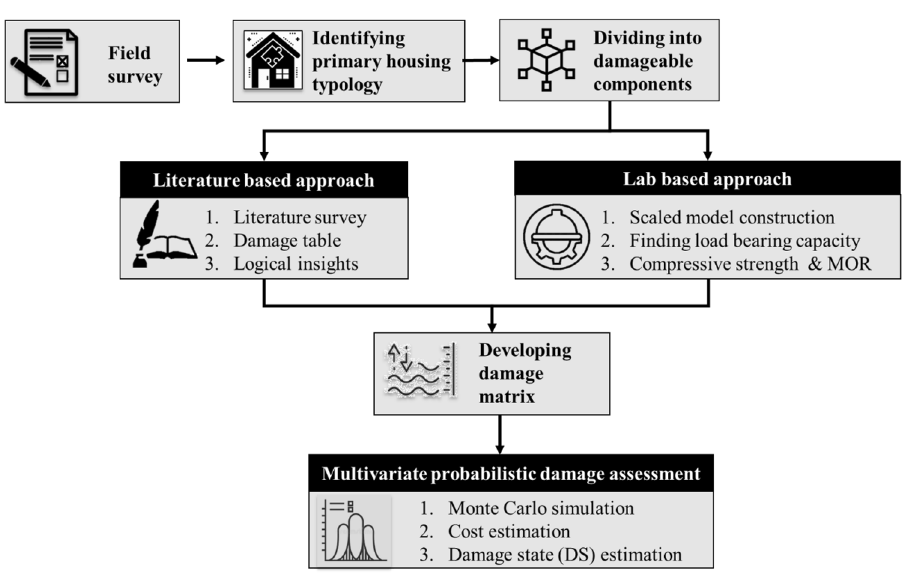
Figure 3. Methodology